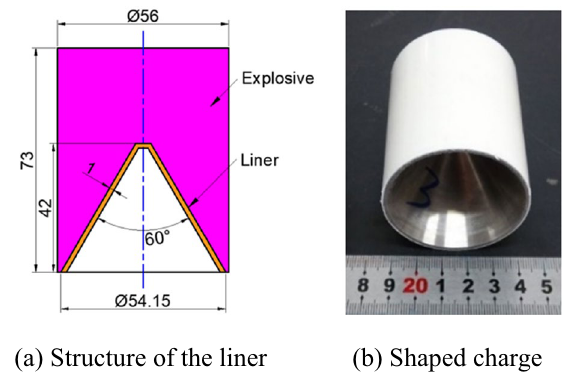
Figure 1. Shaped charge used for the X-ray experiment.